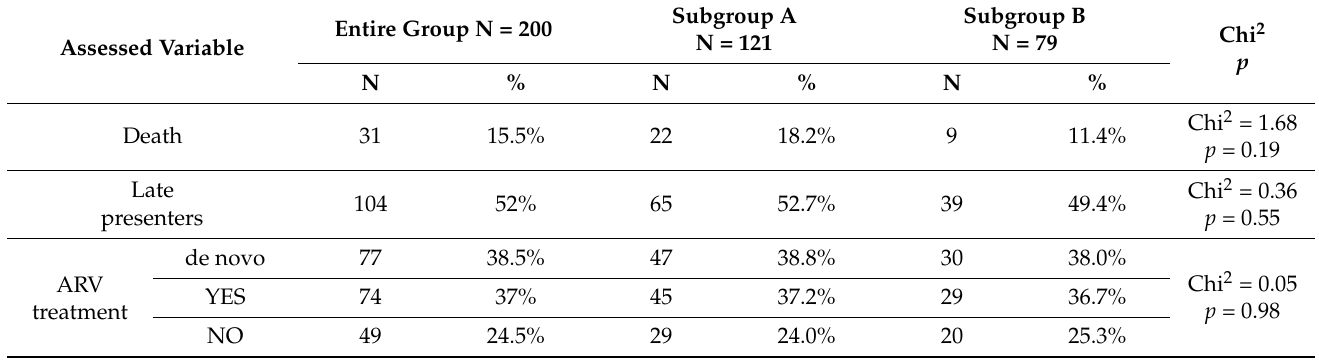
Table 4. Death, late detection of HIV infection, and treatment of ARV in individual patient subgroups.